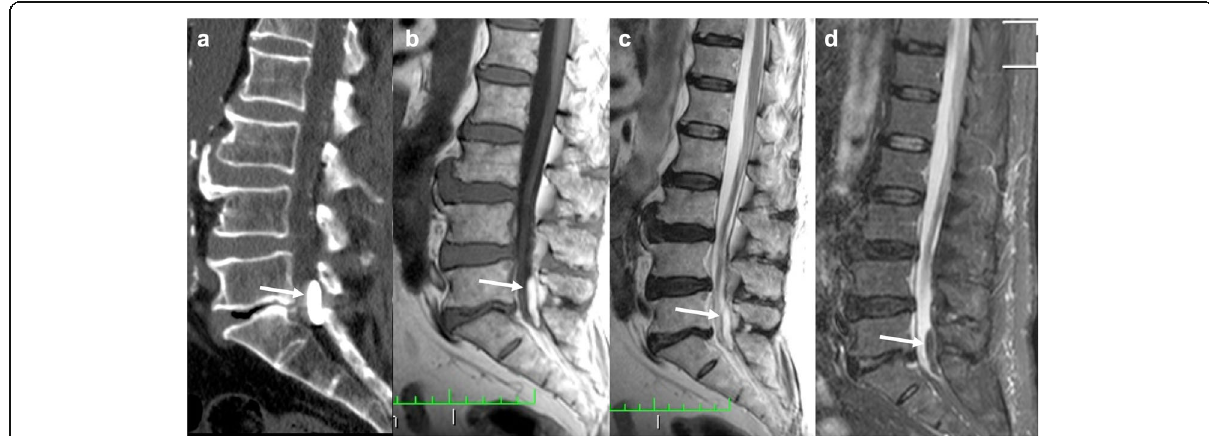
Fig. 8 Lipiodol-induced adhesive arachnoiditis. Sagittal unenhanced CT ( a ), T1-weighted ( b ), T2-weighted ( c ), and STIR-weighted ( d ) images showing a mass in the spinal canal at the level of L5-S1 encasing the corresponding nerve roots. It appears hyperdense on CT and hyperintense on both T1- and T2-weighted sequences with signal suppression on STIR (arrows). The cauda nerve roots appear adherent to each other, consistent with the diagnosis of arachnoiditis